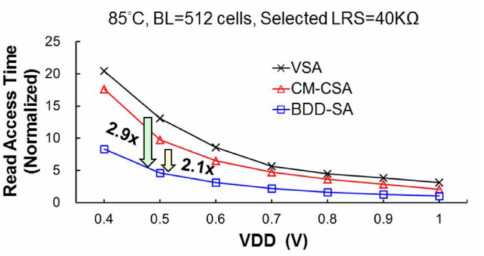
Figure 19. The normalized read access time of a 65 nm 4 Mb macro using various sense amplifiers